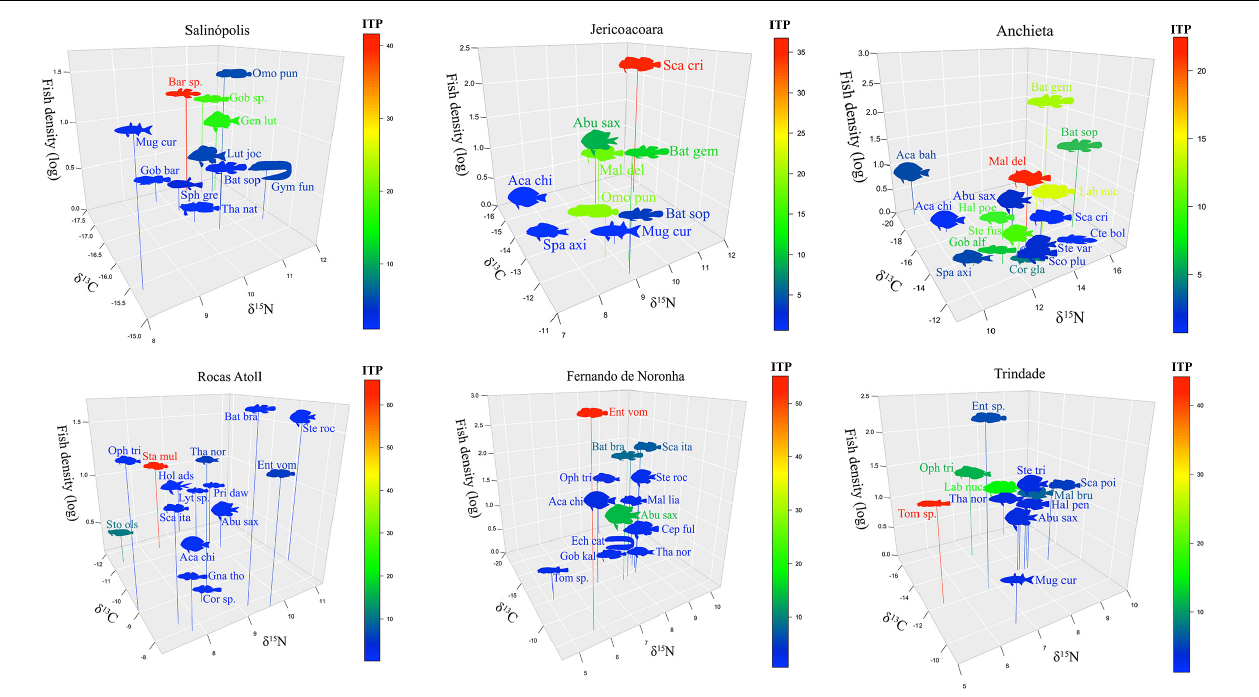
FIGURE 1 | Intraspecific trophic pressure (ITP; fish silhouette color) in 3-D space defined from isotopic niche ( δ 13 C and δ 15 N signatures on the x and y axes, respectively) and density (ind.m − 3 ; z -axis) in six intertidal environments. The color scale indicates the relative ITP intensity at each site (low intensity = coldest color and high intensity = warmest color). Taxa acronyms are given Supplementary Table 1